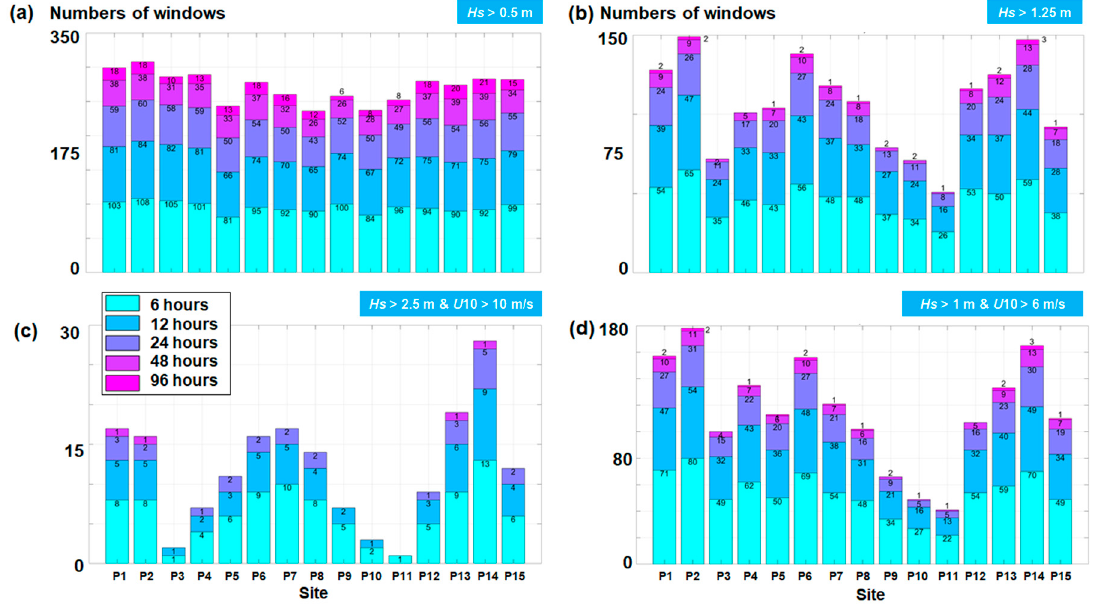
Figure 10. Number of windows reported above a particular threshold, where: ( a ) Hs > 0.5 m; ( b ) Hs > 1.25 m; ( c ) Hs > 2.5 m and U 10 > 10 m/s; ( d ) Hs > 1 m and U 10 > 6 m/s.